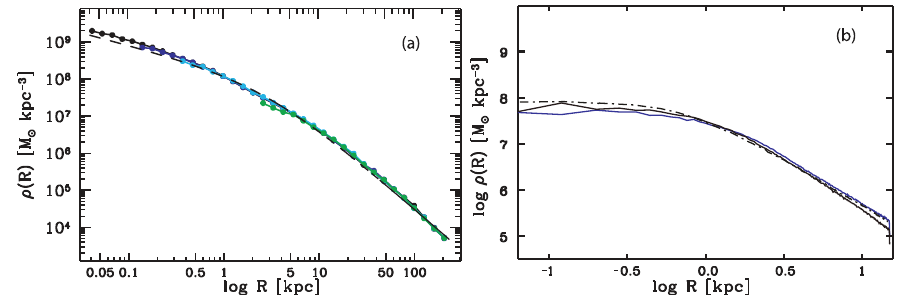
Fig. 1. Comparison of the dark matter density profile of our model with simulations. Panel (a) plots the result of Stadel et al. (2009) dissipationless simulations (solid line), and that of our model (dashed line). Panel (b) plots the result of our model (dot-dashed line) and galaxy DG1 (solid blue line) and galaxy DG2 (solid black line) of Governato et al. (2010) SPH